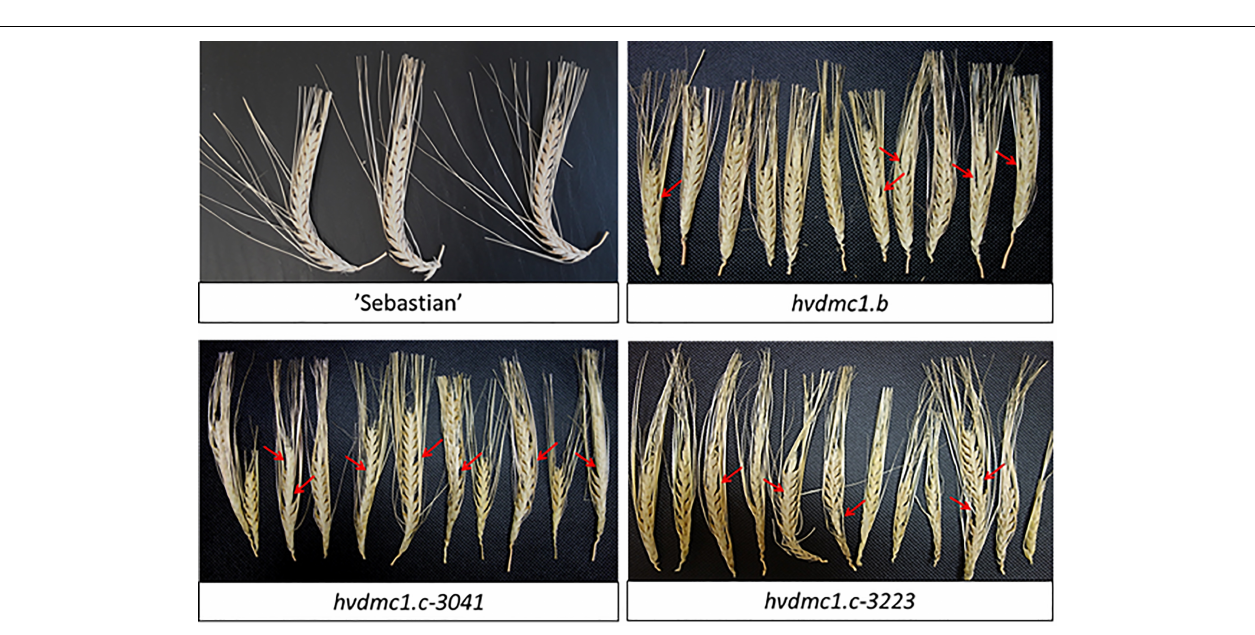
FIGURE 3 | Multiple alignment of fragment of the DMC1 protein sequences from various species with positions of substituted amino acids in the dmc1.b and dmc1.c mutants indicated with red frames. Hs – Homo sapiens, Zm – Zea mays, Hv – Hordeum vulgare, Ta – Triticum aestivum, Os – Oryza sativa, At – Arabidopsis thaliana, Nt – Nicotiana tabacum .